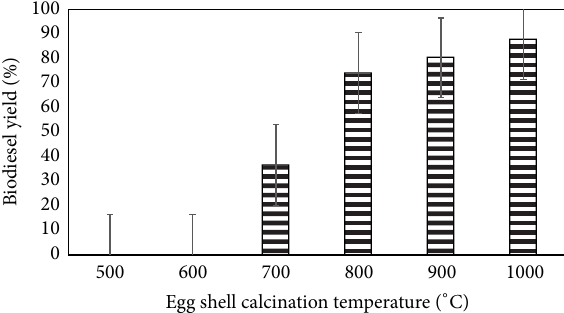
Figure 5: Single-step transesterification of sunflower oil using egg shells calcinated at different temperatures. Experimental conditions: temperature 60 ∘ C, methanol/oil ratio 6: 1, catalyst load 5% (wt/wt), and time 120 minutes.